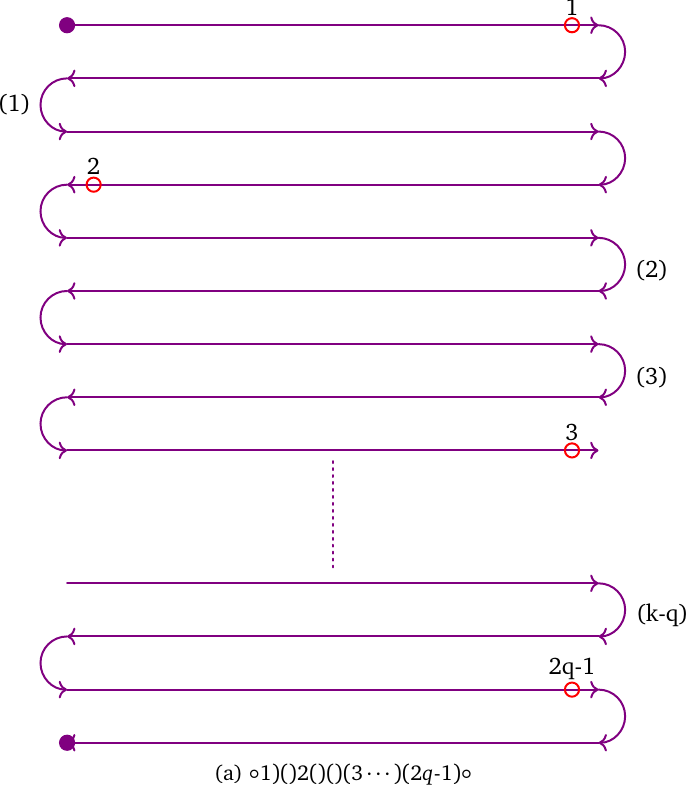
Figure 4: Arranging ( k − q ) empty timefolds between ( 2 q − 1 ) turning-point oper- ators (which are in the canonical arrangement). We have labeled the i th turning- point operator and the j th timefold is denoted by ( j ) . For the case of minimal n , i.e., n = 2 q − 1 with all operators being turning-point operators, the counting